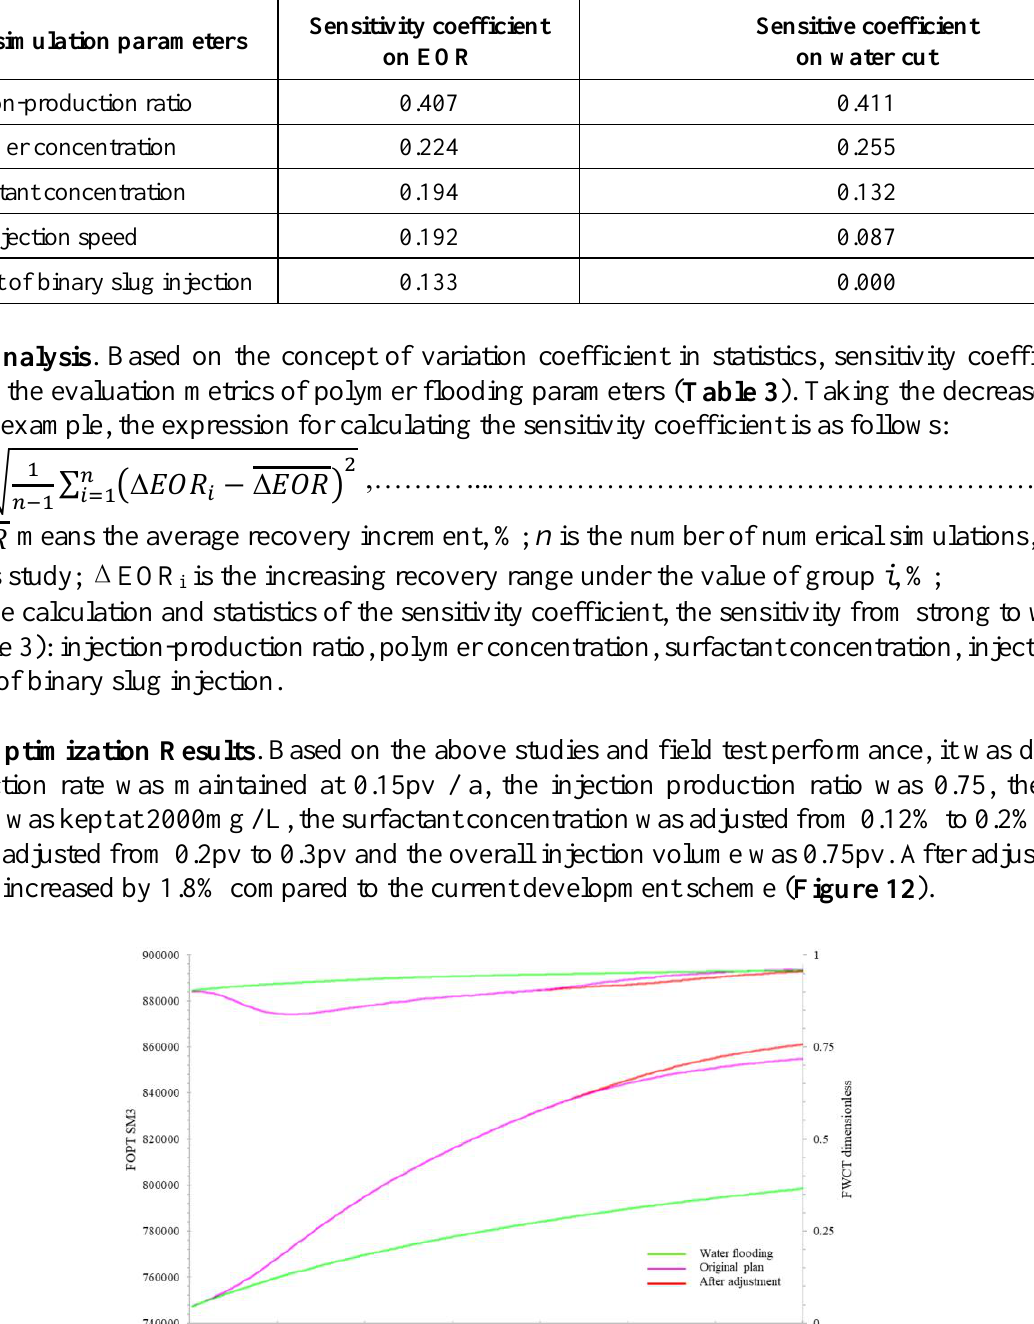
Table 3—Rank of influencing factors in numerical simulation.